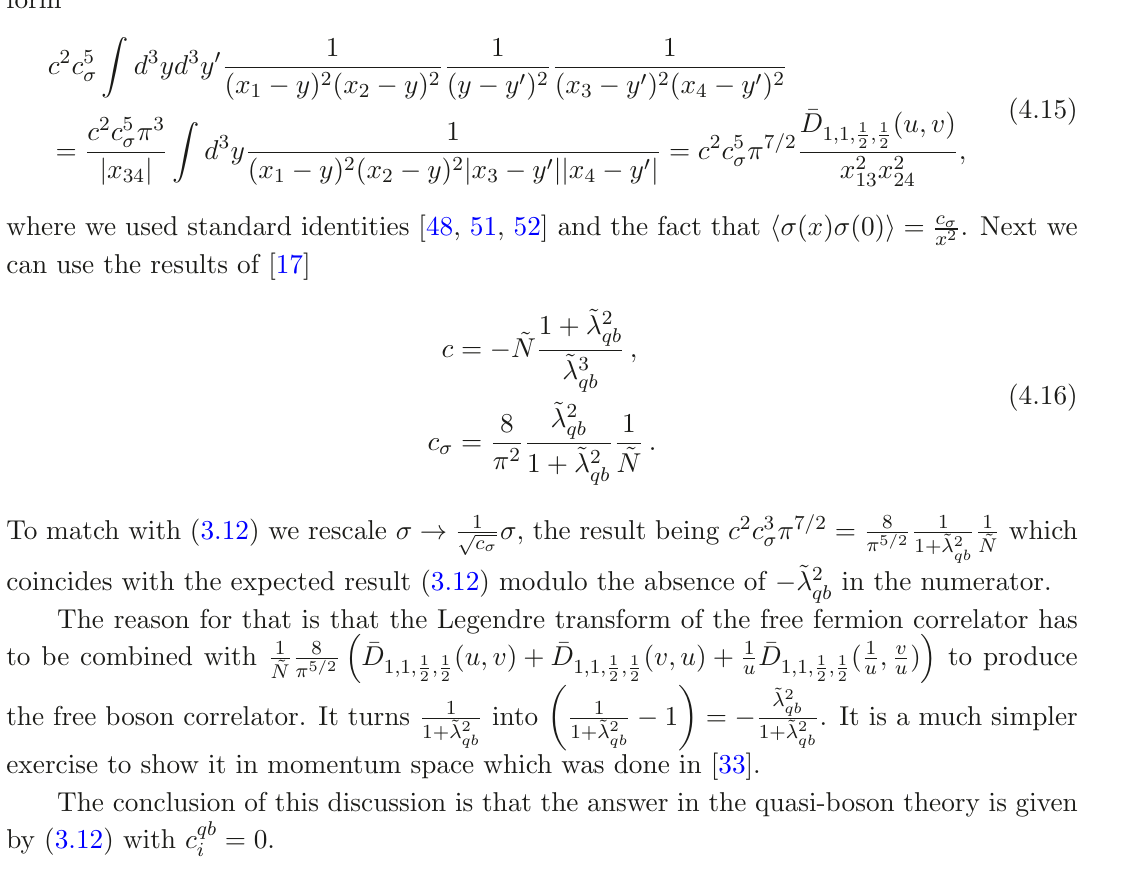
Figure 5 . The vertices are given by (4.14). The propagators are over the position of the